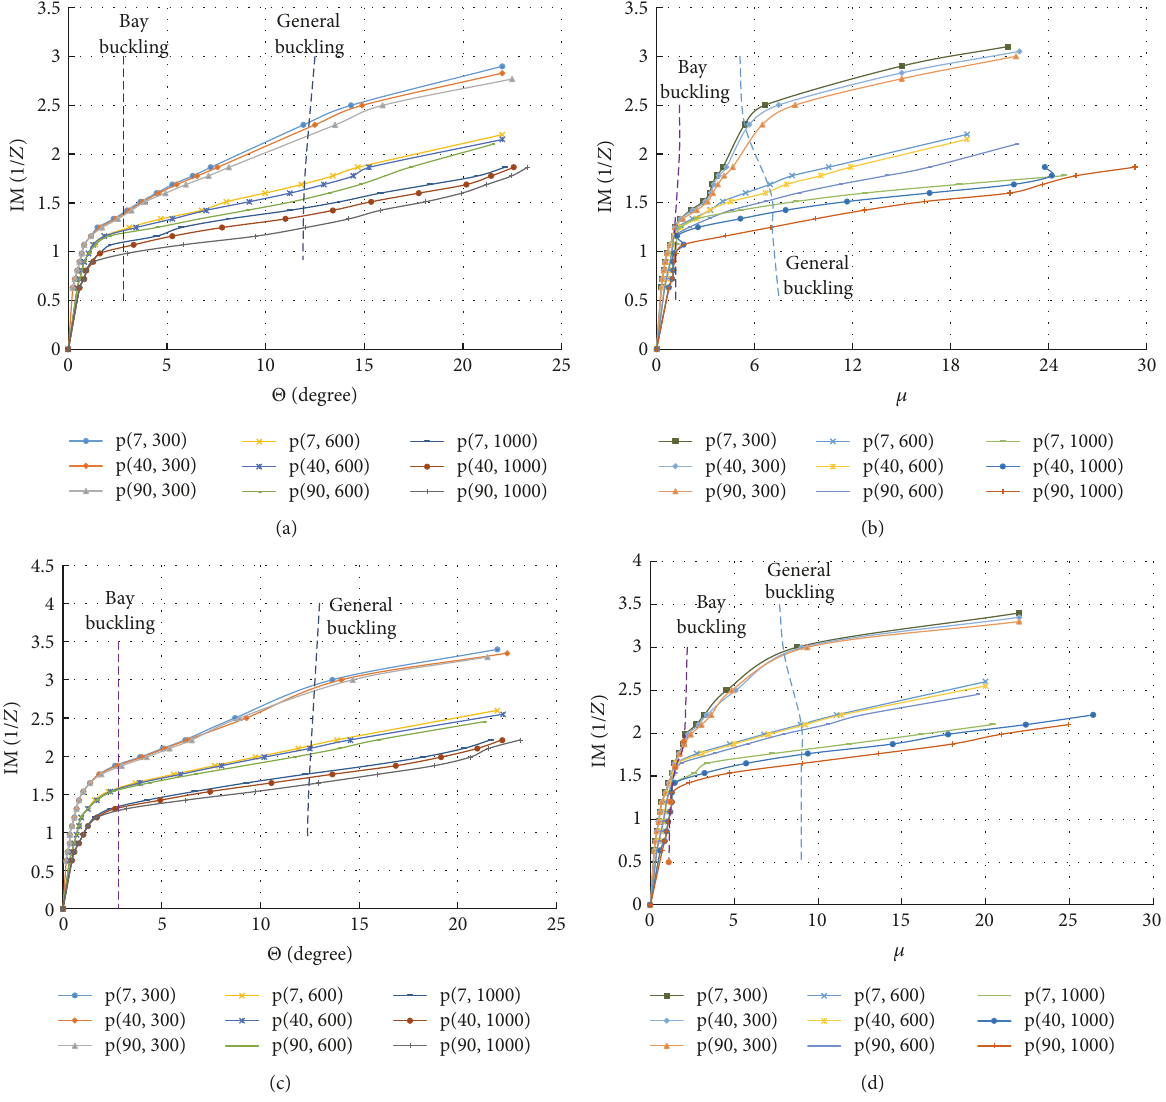
Figure 9: IEA curves obtained for unstiffened shell for all (𝛽, SD ) ’s: 4 mm, (a) IM- 𝜃 and (b) IM- 𝜇 ; 6.5 mm, (c) IM- 𝜃 and (d) IM- 𝜇